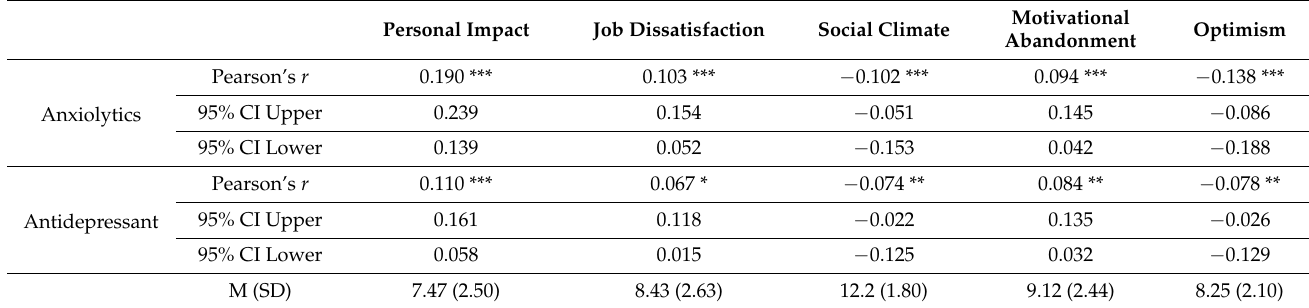
Table 1. Correlation matrix.